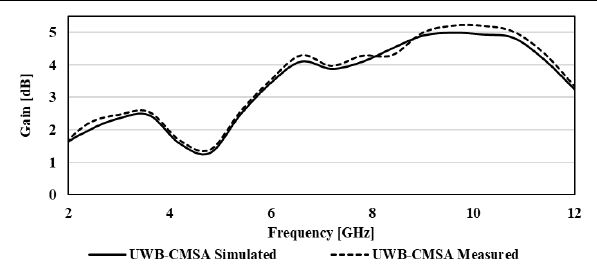
Figure 4. Variation in Impedance v/s frequency.